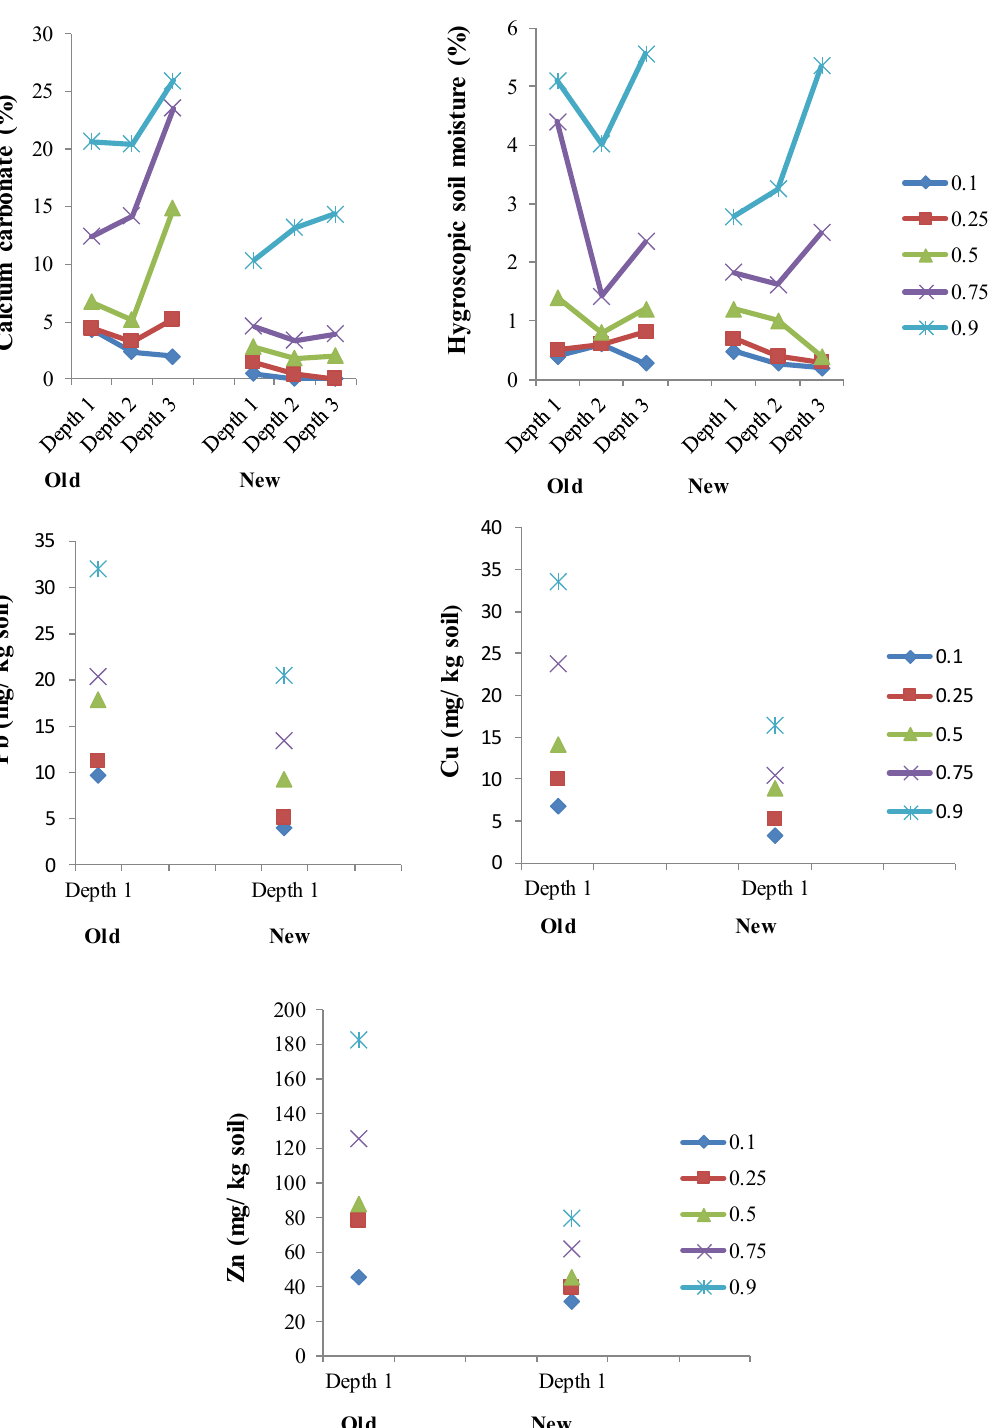
Figure 2. Deciles of soil properties for each neighborhood. EC = electrical conductivity, PD = penetration depth; BD = bulk density, CC = calcium carbonate, FWC = field water content, OM = organic matter, HSM = hygroscopic soil moisture, Pb = lead, Cu = copper, and Zn = zinc.